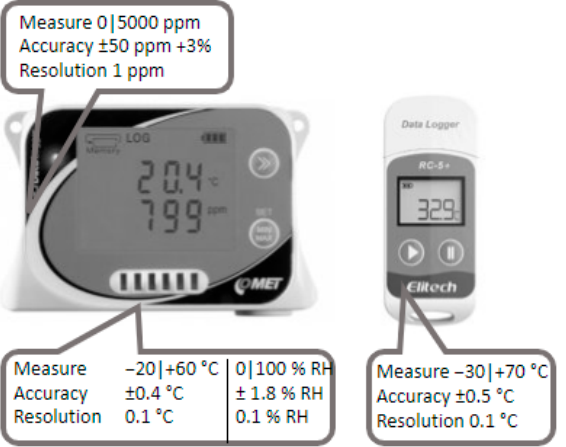
Figure 1. Equipment used and Specifications.